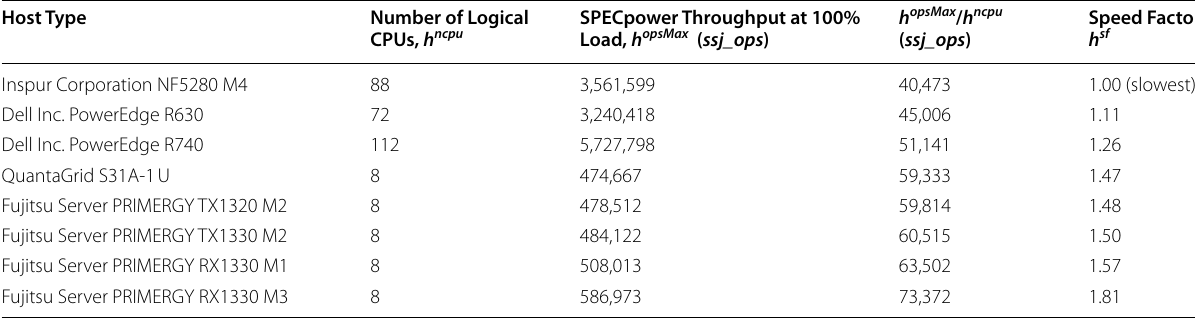
Table 6 Host parameters, in decreasing order of speed factor (Definitions in Tables 2 and 3) Host Type